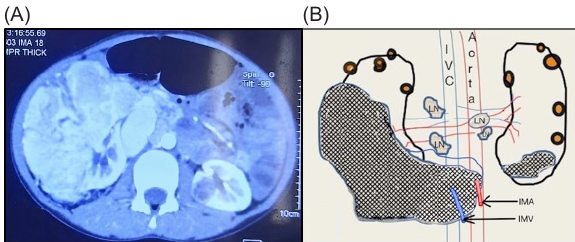
Figure 1: (A) CECT (axial section) demonstrating a heteroge- neously enhancing in right kidney with foci of calcification.